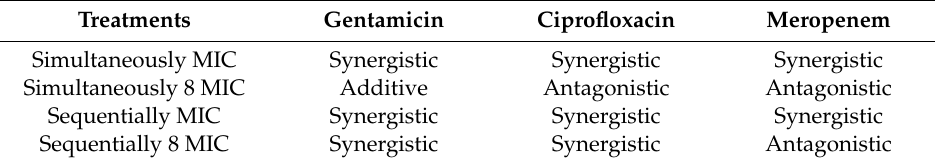
Table 3. General overview of the e ffi cacy of combined treatments in 48 h P. aeruginosa